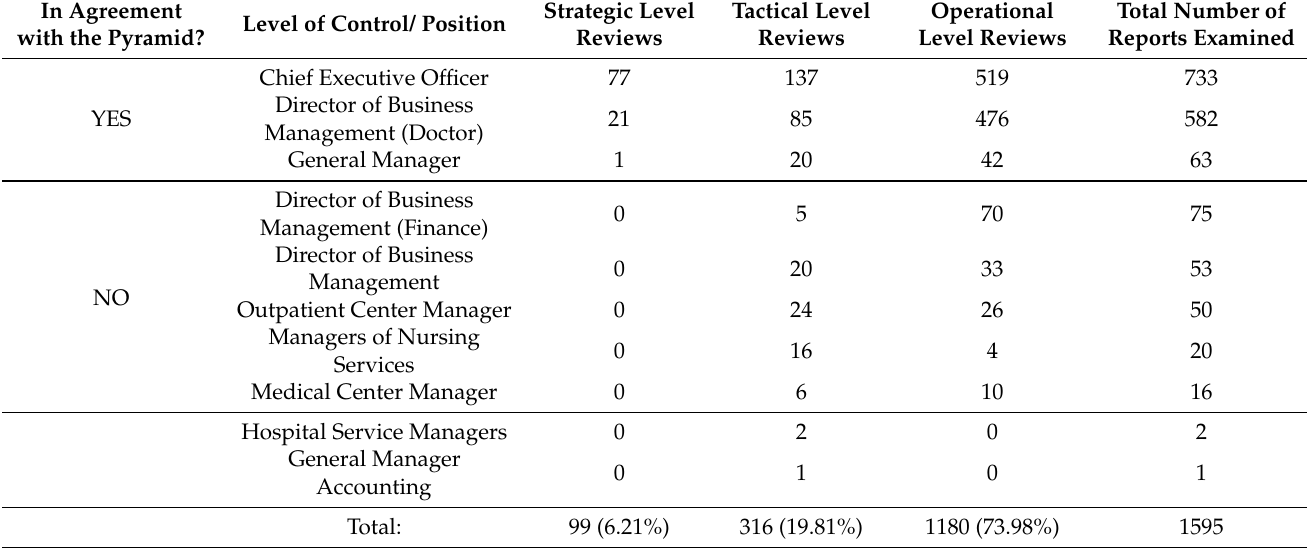
Table 5. Number of reports examined with respect to